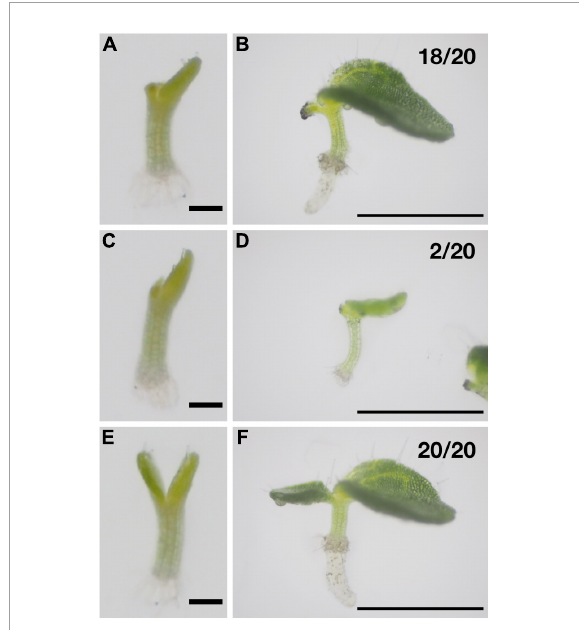
FIGURE1 Both of the cotyledons have the same potential to become a macrocotyledon at the early isocotylous stage in M. glabra . (A, B) One of the cotyledons was removed at 6 DAS (A) , and the remaining cotyledon became the macrocotyledon by 10 days after cutting (DAC) (B) . (C,D) One of the cotyledons was removed at 6 DAS (C) , and the remaining cotyledon became